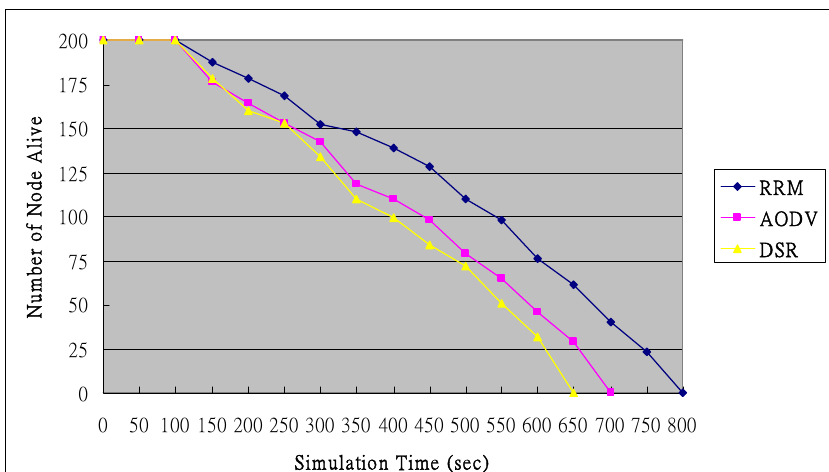
Figure 20. Number of node